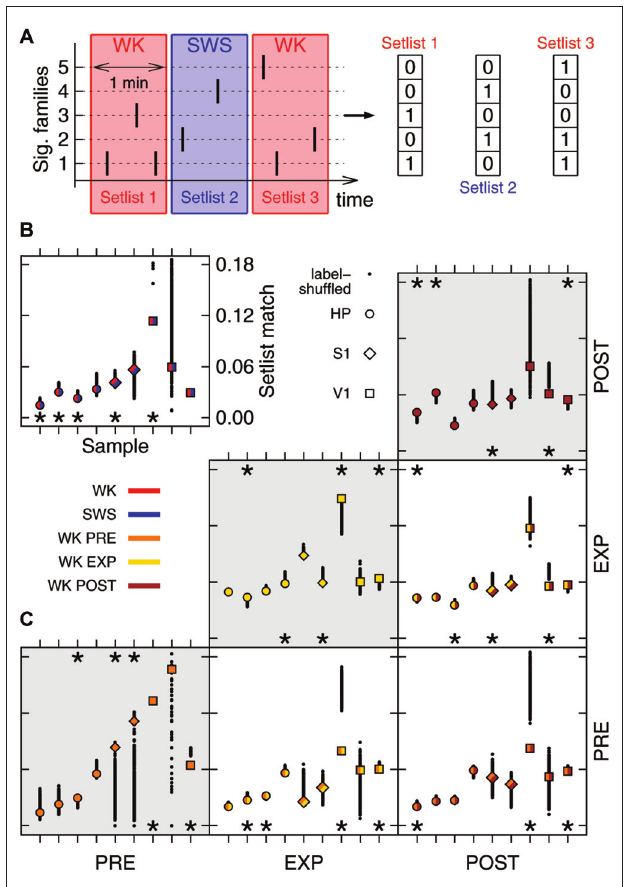
FIGURE 3 | Family repertoire is behavior-dependent. (A) Setlists are defined as binary vectors composed of 1s (or 0s) for each significant family observed (or absent) in a given 1 min time window. (B) Mean similarity between WK and SWS setlists (label-shuffled data shown in black). Significant cases ( p = 0.025) are indicated by asterisks on top (similar setlists) or bottom (dissimilar setlists) of the plot. All data samples represented; symbols indicate brain region, colors indicate condition. (C) Same as in (B) , now comparing WK setlists through different experiment stages (PRE, EXP and POST). Gray areas indicate comparisons within the same stage.